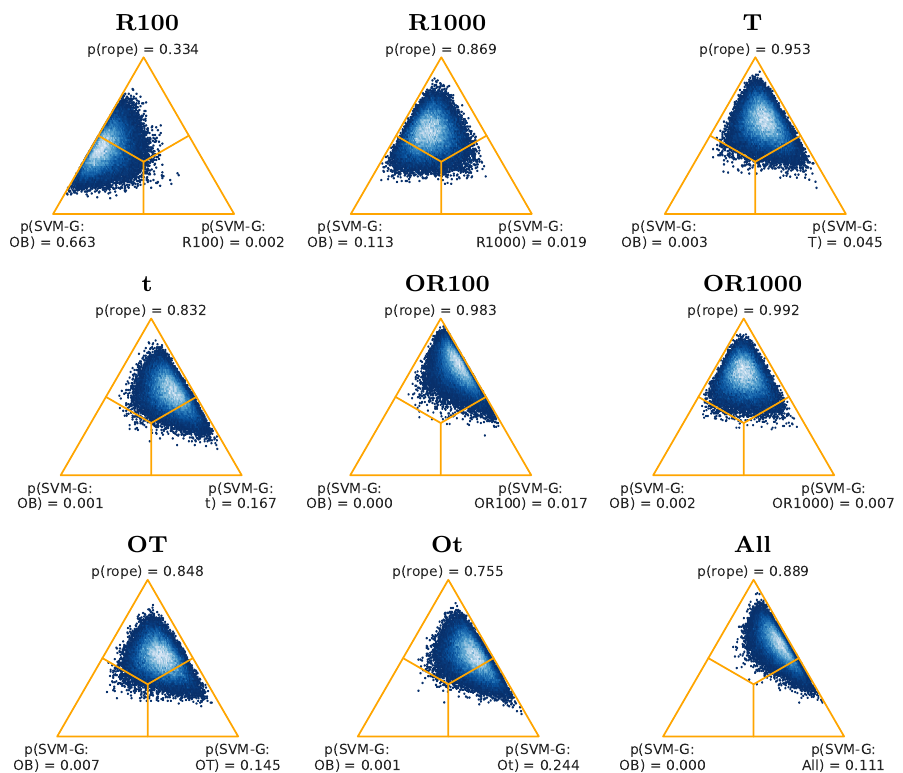
Figure 8. Posteriors for the Bayesian sign-rank tests for SVM-G, from all the